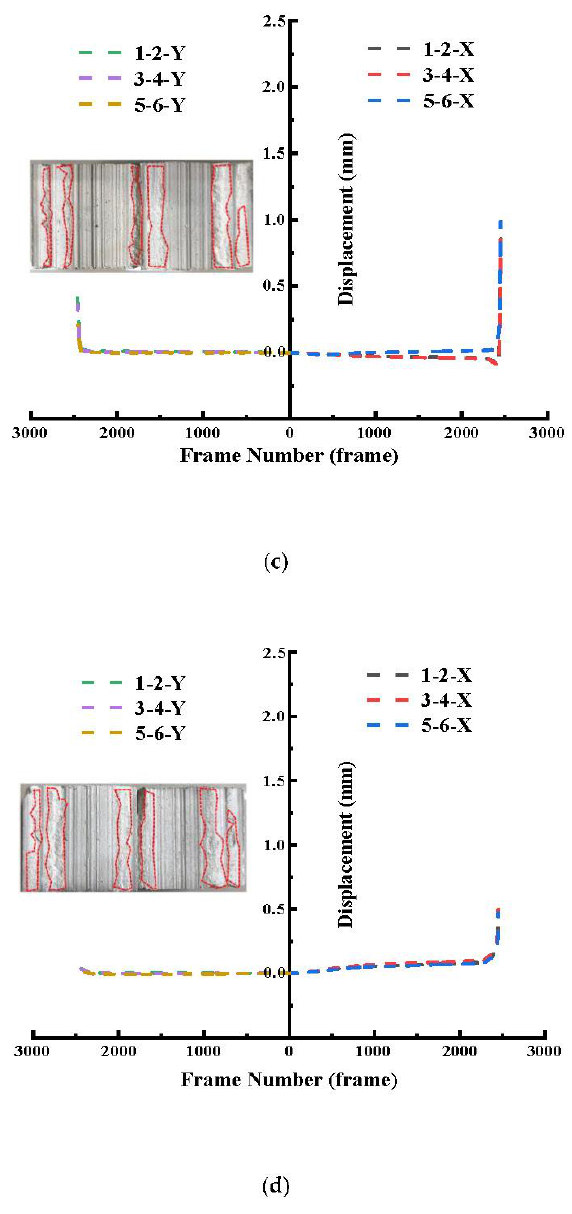
Figure 10. Relative displacement changes of measuring points in X and Y directions under different initial shear stress conditions. ( a ) τ i = 0.6 MPa. ( b ) τ i = 0.9 MPa. ( c ) τ i = 1.2 MPa. ( d ) τ i = 1.5 MPa . initial shear stress conditions. ( a ) τ